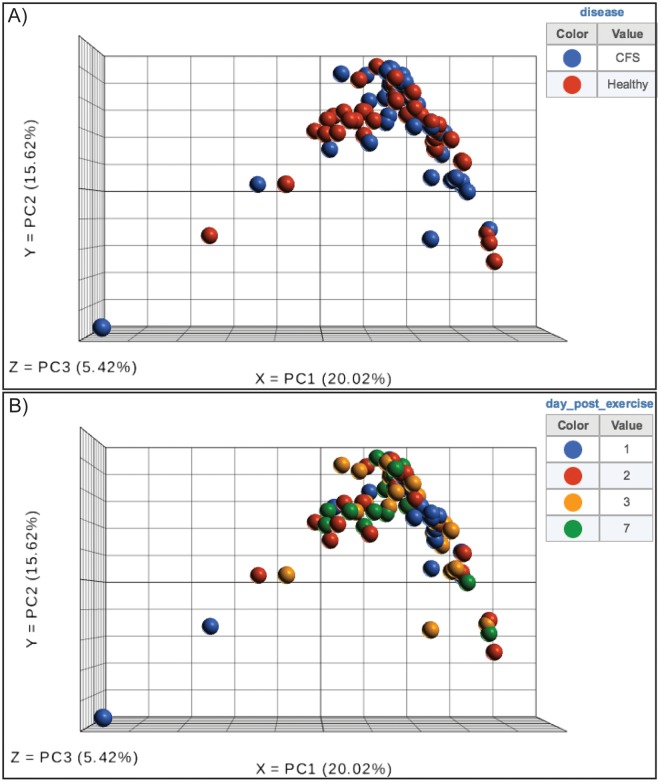
Principal component analysis of the global gene expression shows no sampling bias between CFS patients and controls (A), nor between time points (B).